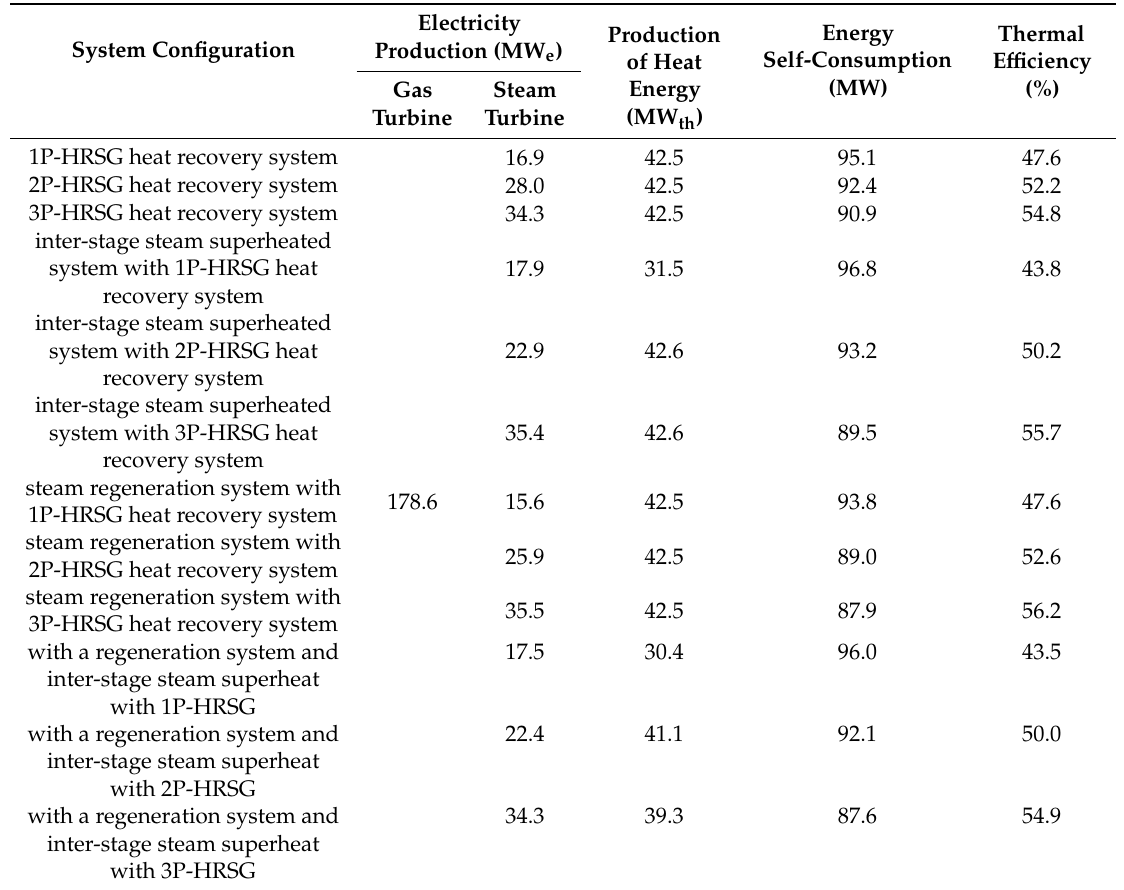
Table 6. Working parameters and assumptions for thermodynamic